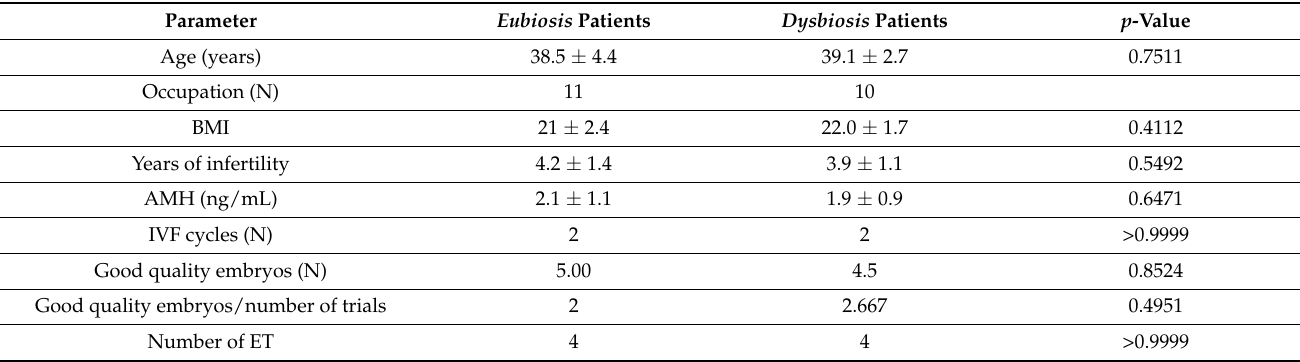
Table 2. Descriptive statistics of clinical parameters for the two study groups. The data are expressed as mean ± SD. Good quality embryos, number of IVF cycles, number of embryo-transfer (ET), good quality embryos/number of trials are expressed as median values. AMH: anti-Mullerian hormone; ET: embryo-transfer; IVF: in vitro fertilization; BMI, body mass